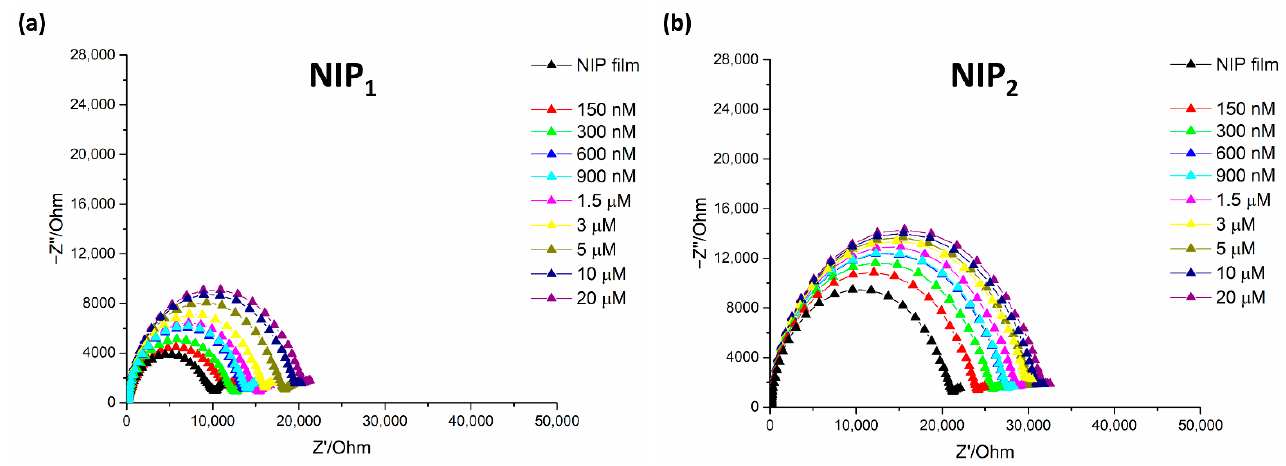
Figure 5. Nyquist impedance plot in 5 mM of [Fe(CN) 6 ] 3 − / 4 − for Lyz detection at different concentration on ( a ) NIP 1 sensors and ( b ) NIP 2 sensors. Frequency range: from 0.1 Hz to 50 kHz. AC potential: 10 mV and DC potential: 0.18 V.